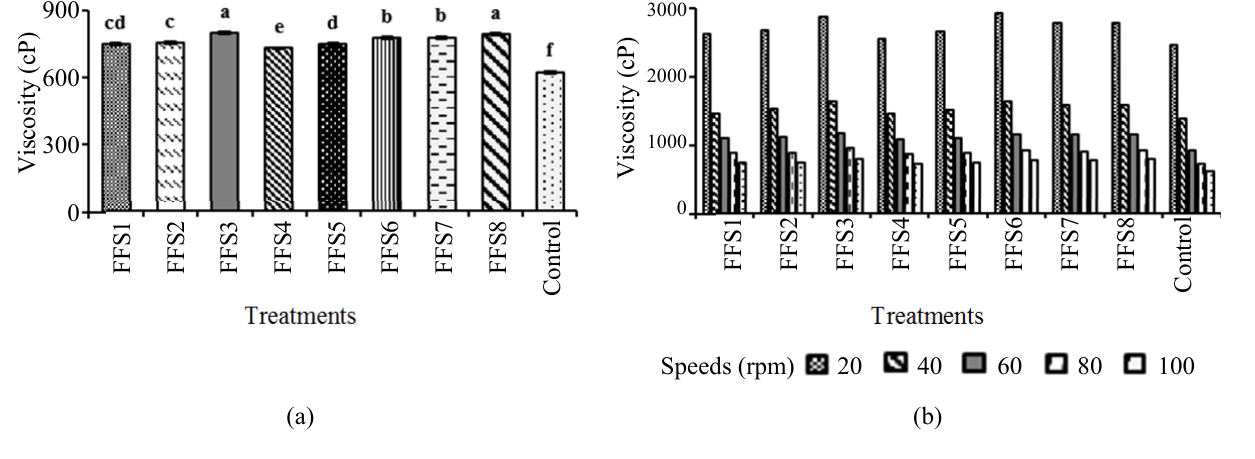
Fig. 6. Viscosity property of the fortified Vietnamese tamarind fish sauce. Table 4. Sensory acceptability scores of fortified Vietnamese tamarind fish sauces Treatments